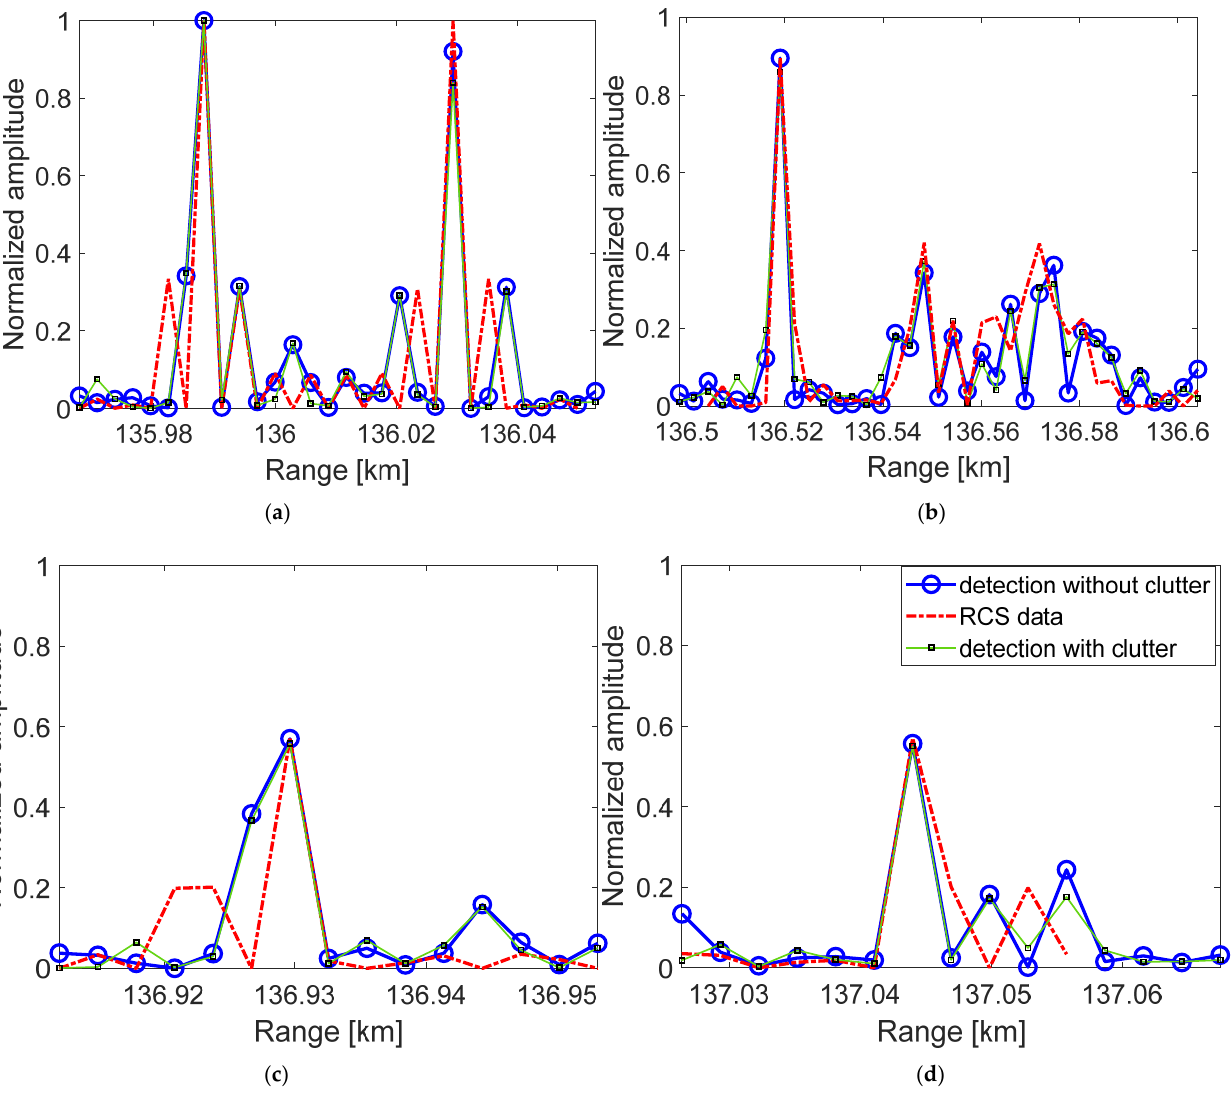
Figure 14. Range inversion results of 3 ship targets under the detection of BDS satellite 3 with range inversion method 1: ( a ) ship 1; ( b ) ship 3; ( c ) left part of ship 2; ( d ) right part of ship